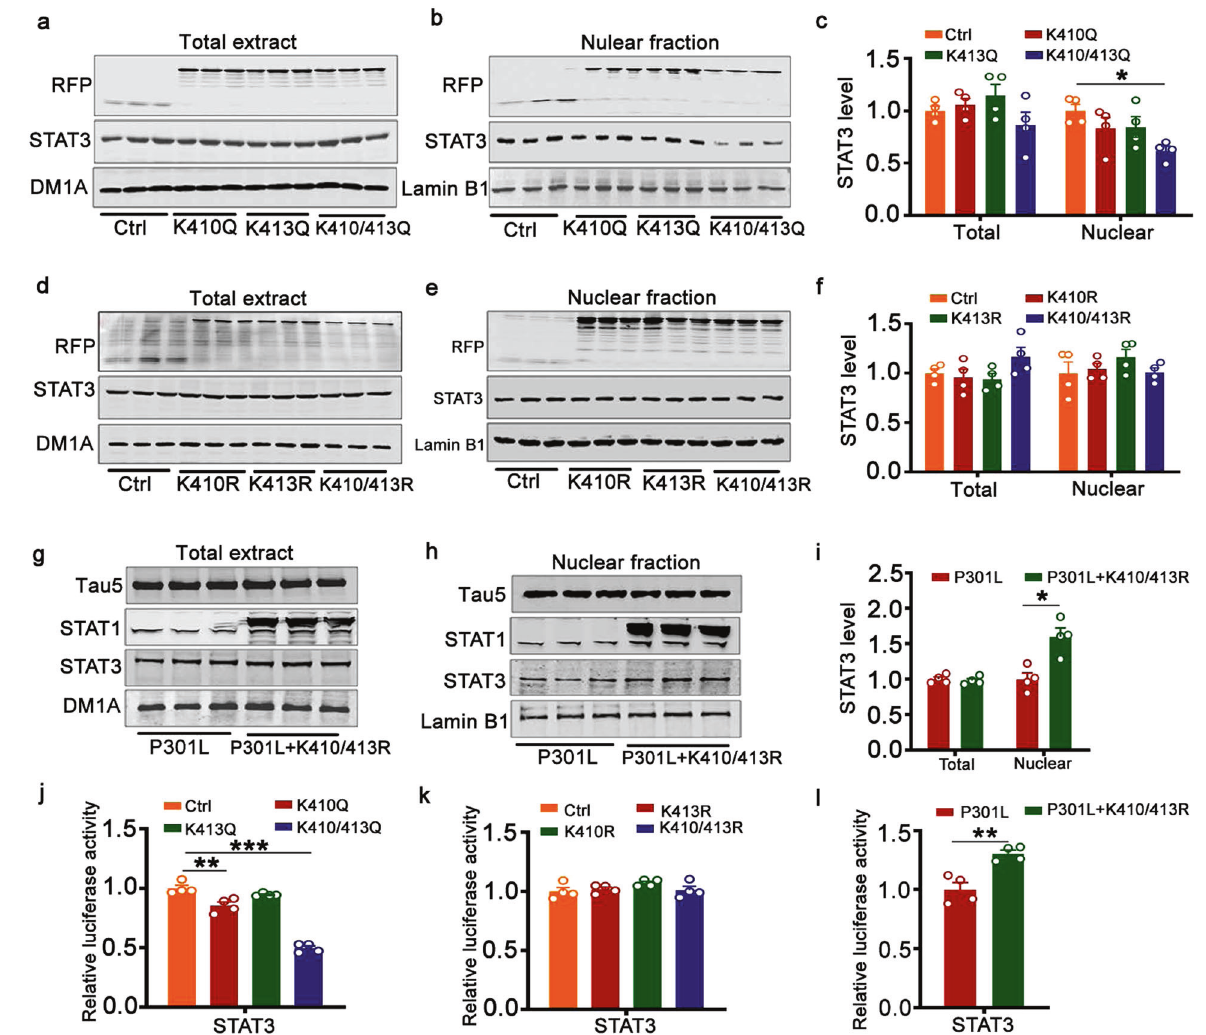
Fig. 3 Acetylated STAT1 inhibited STAT3 nuclear translocation. Pseudoacetylated STAT1 mutant (K410/413Q) decreased total STAT3 in the nuclear fraction ( b ) but had no effect on the total STAT3 level in the whole extracts of HEK293 cells ( a ) detected by Western blotting and quantitative analysis ( c ). c One-way analysis of variance (ANOVA) followed by the Bonferroni ’ s post hoc test, nuclear STAT3 level [K410/413Q] p = 0.027, n = 4. The unacetylated (K410R, K413R, K410/413R) STAT1 mutant did not change STAT3 levels in total extracts ( d ) or the nuclear fraction ( e ), as determined by Western blotting and quantitative analysis ( f ). K410/K413R-STAT1 (K410/413R) restored P301L-induced reduction of decreased STAT3 in the nuclear fraction, as determined by Western blotting ( g , h ) and quantitative analysis ( i ). i Two-tailed Student ’ s t test, nuclear STAT3 level p = 0.044, n = 4. j K410/K413Q-STAT1 decreased the luciferase activity of STAT3. One-way analysis of variance (ANOVA) followed by the Bonferroni ’ s post hoc test, STAT3 luciferase activity [K410Q] p = 0.002; [K410/413Q] p < 0.001, n = 4. k Unacetylated (K410R, K413R,